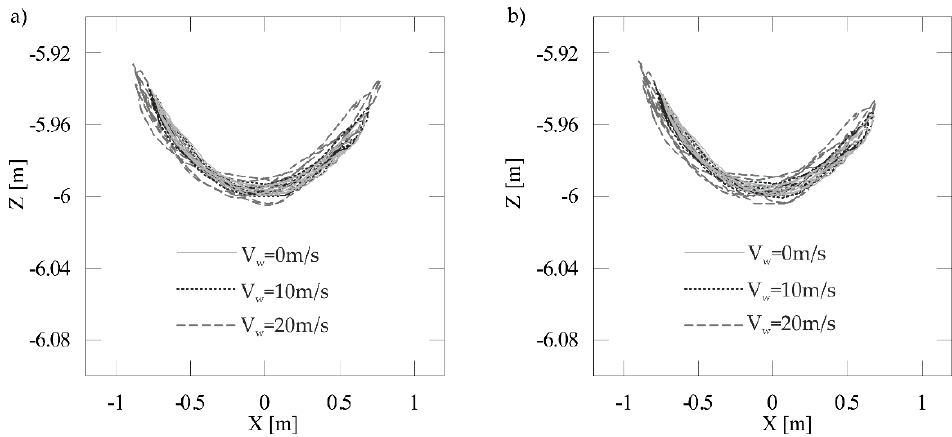
Figure 6. Projection of the trajectory of the carried load’s suspension point on one of the lifting planes for ( a ) the variable effective area and ( b ) fixed effective area.